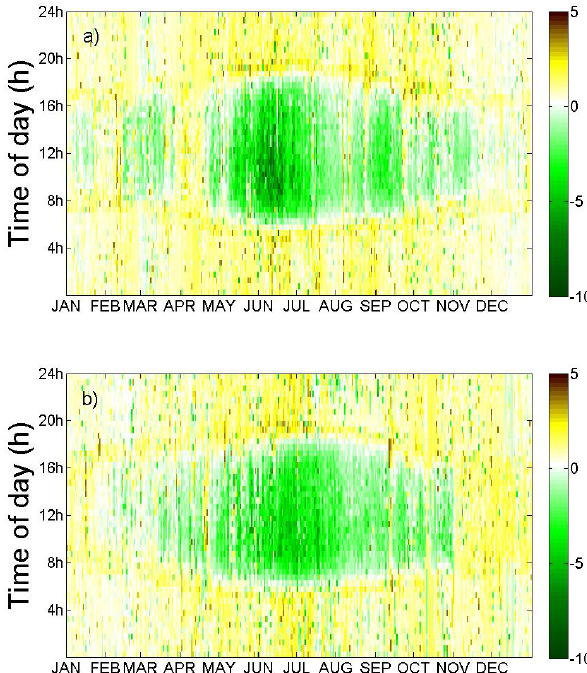
Fig. 3. Annual and daily evolution of NEE (µmolm − 2 s − 1 ) by the Figure 3. Annual and daily evolution of NEE ( µ mol m -2 s -1 ) by the alpine Mediterranean shrubland alpine Mediterranean shrubland located in the Sierra Nevada moun- located in the Sierra Nevada mountain range during (a) 2007 and (b) 2008. tain range during (a) 2007 and (b)